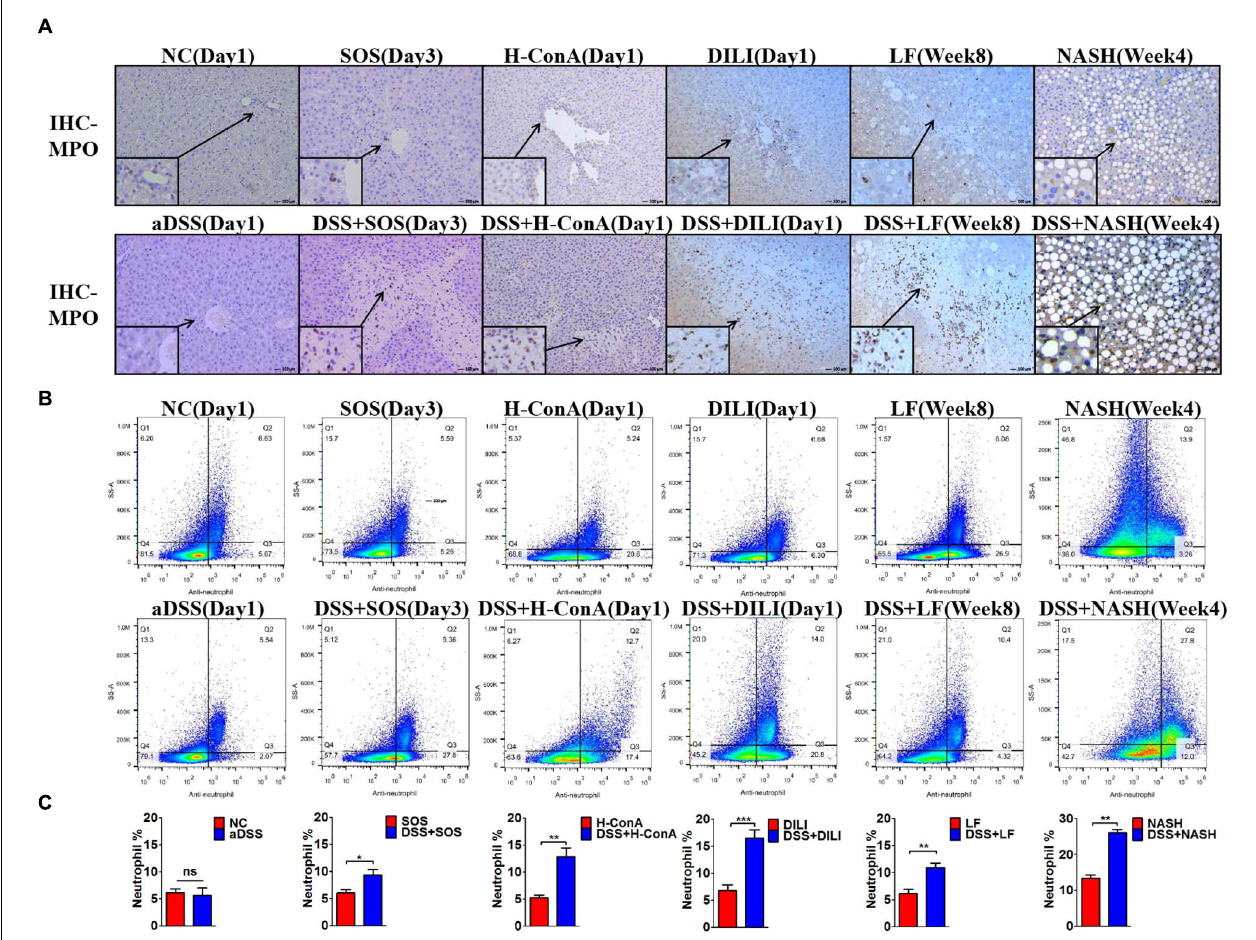
FIGURE 2 | Increased hepatic neutrophils were observed in colitis-induced liver injury. The infiltration and number of hepatic neutrophils were assessed by (A) immunohistochemistry (IHC) for myeloperoxidase (MPO) and (B,C) flow cytometry (anti-neutrophil + SSA high ) in the following groups: normal control (NC), acute dextran sulfate sodium (DSS) colitis (aDSS), sinusoidal obstruction syndrome (SOS), DSS + SOS, high-dose ConA hepatitis (H-ConA), DSS + H-ConA, drug-induced liver injury (DILI), DSS + DILI, liver fibrosis (LF), DSS + LF, non-alcoholic steatohepatitis (NASH), and DSS + NASH. ns, non-significant; * p < 0.05; ** p < 0.01; *** p < 0.001 by t -test; n = 5–6 in each group; figures are representative of three